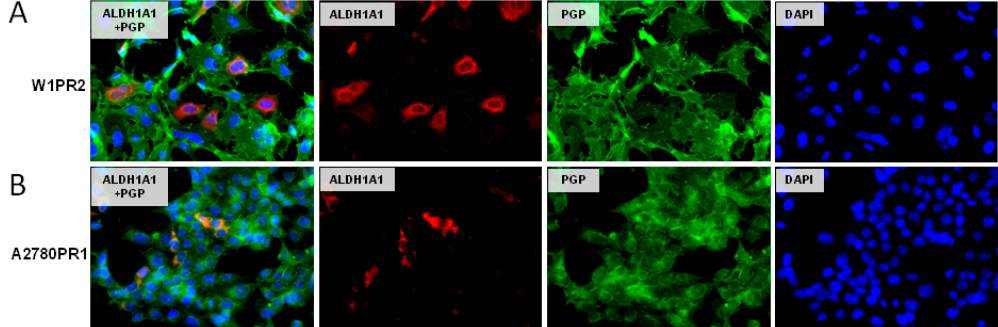
Figure 5. Immunofluorescence visualization of P-gp and ALDH1A1 coexpression in the W1PR2 ( A ) and A2780PR1 ( B ) cell lines. P-gp was detected using the anti-P-gp antibody and Alexa Fluor ® 488-conjugated secondary antibody (green). ALDH1A1 was detected using the anti-ALDH1A1 antibody and Alexa Fluor ® 594-conjugated secondary antibody (red). To visualize the cell nuclei, the cells were mounted with a DAPI-containing mounting medium (blue). Objective 40×.